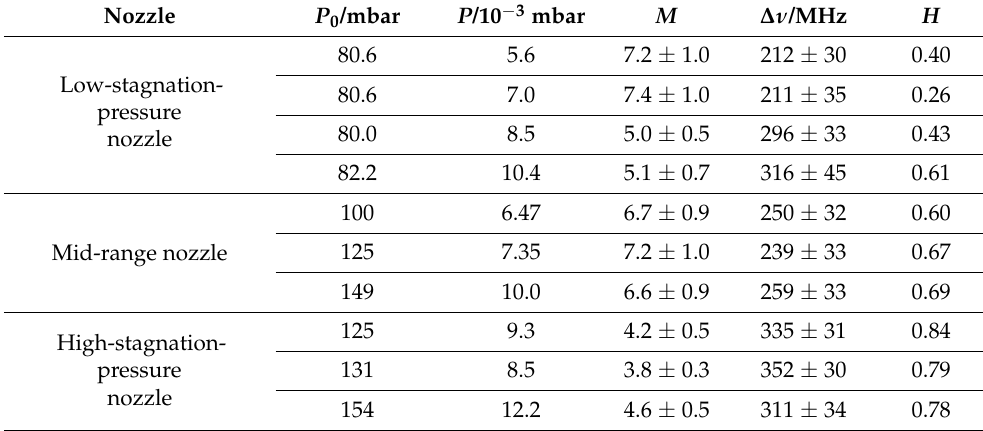
Figure 5. ( a ) Intensity-weighted averages of the resolution for the low-stagnation-pressure nozzle. The resolution generally improves as the background pressure is reduced. ( b ) Resolution along the jet for different parameters of the low-stagnation-pressure nozzle. ( c ) Example Gaussian fit of the intensity as a function of the laser frequency for the low-stagnation-pressure nozzle at P 0 = 80.6 mbar and P = 5.6 × 10 −3 mbar. In both pictures, the parameters are as follows: black: P 0 = 80.6 mbar and P = 5.6 × 10 −3 mbar; red: P 0 = 80.6 mbar and P = 7.0 × 10 −3 mbar; green: P 0 = 80.0 mbar and P = 8.5 × 10 −3 mbar; blue: P 0 = 82.2 mbar and P = 10.4 × 10 −3 mbar. Table 1. Intensity weighted averages of M , ∆ ν and H for the three different